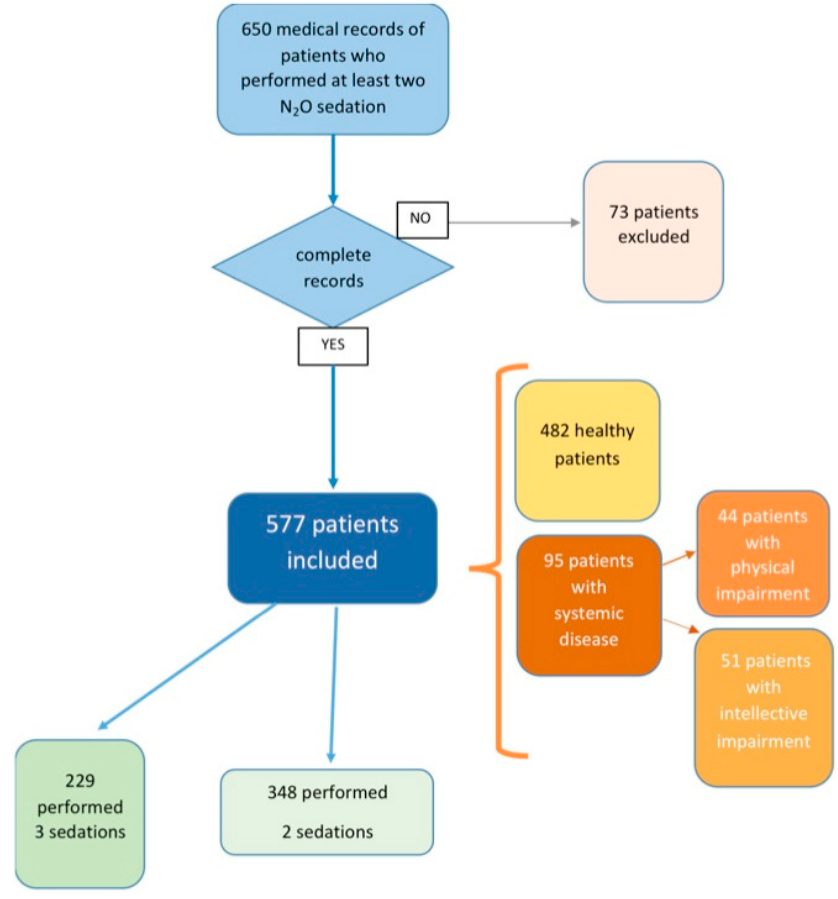
Figure 1. Flow chart of the study design.